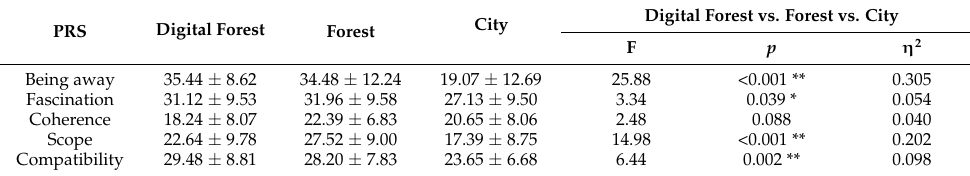
Digital Forest vs. Forest vs. City